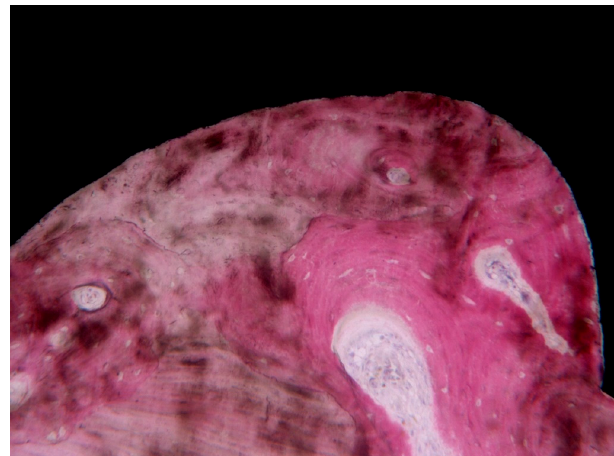
Figure 5. Bone remodeling areas and marrow spaces were present near the implant surface: No gaps were evident at the interface. A rim of osteoblasts making new osteoid matrix on the implant surface was evidenced. Implant was retrieved for a change in the prosthetic design after 22 years. The implant supported a bridge. Courtesy of Dr. Carlo Mangano (toluidine blue and acid fuchsin staining, magnification 100×).